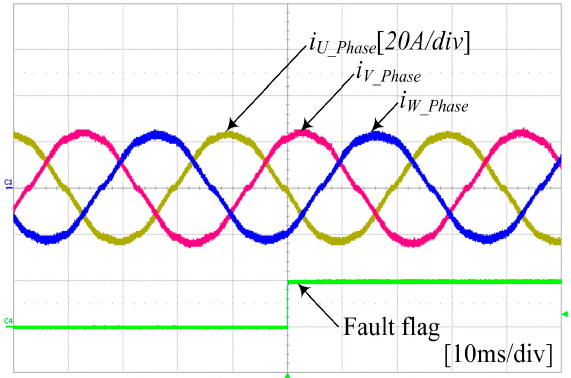
Figure 28. Experimental waveform of phase current applying conventional neutral-point voltage-shifting